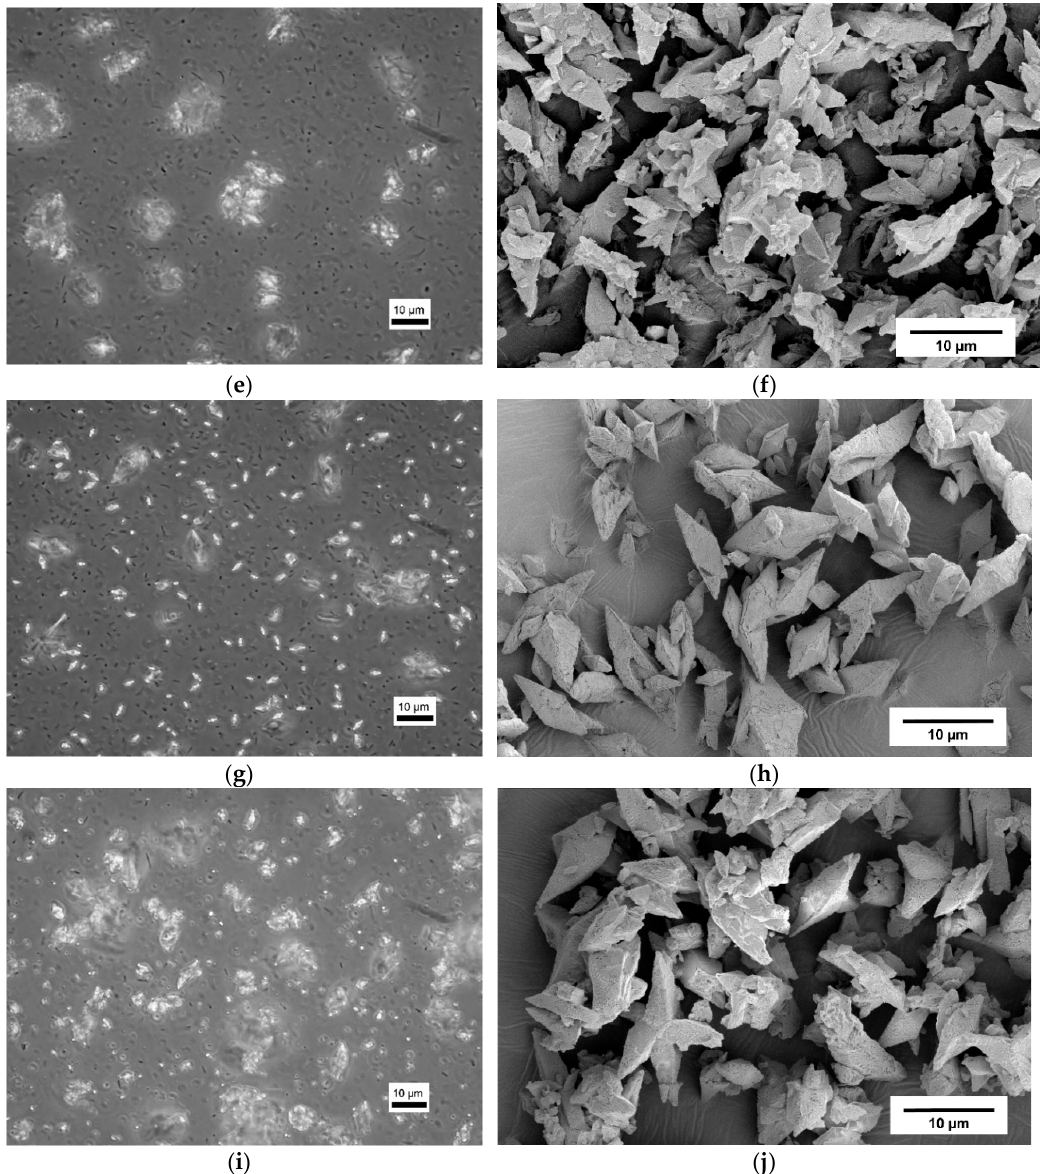
Figure 4. Light microscopy ( a , c , e , g , i ) and scanning electron microscopy ( b , d , f , h , j ) pictures of samples. From top to bottom: Paper mill 1 ( a , b ), Landfill ( c , d ), Cadaver ( e , f ), Paper mill 2 ( g , h ) and Paper mill 3 ( i , j ). The samples are presented from lowest to highest sulfur concentration. The sulfur concentrations of Paper mill 1, Land fill, Cadaver, Paper mill 2, and Paper mill 3 are 1.5, 11.1, 14.5, 16.9, and 29.4 mg g − 1 , respectively.